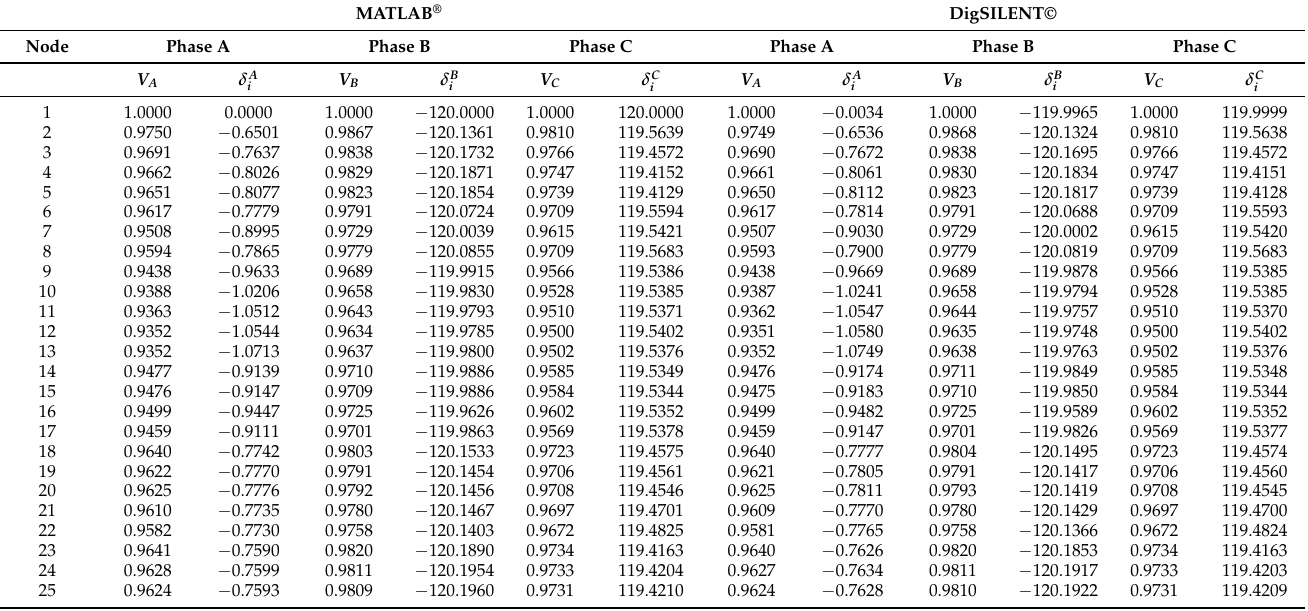
Table 6. Nodal voltage per phase in the 25-node test